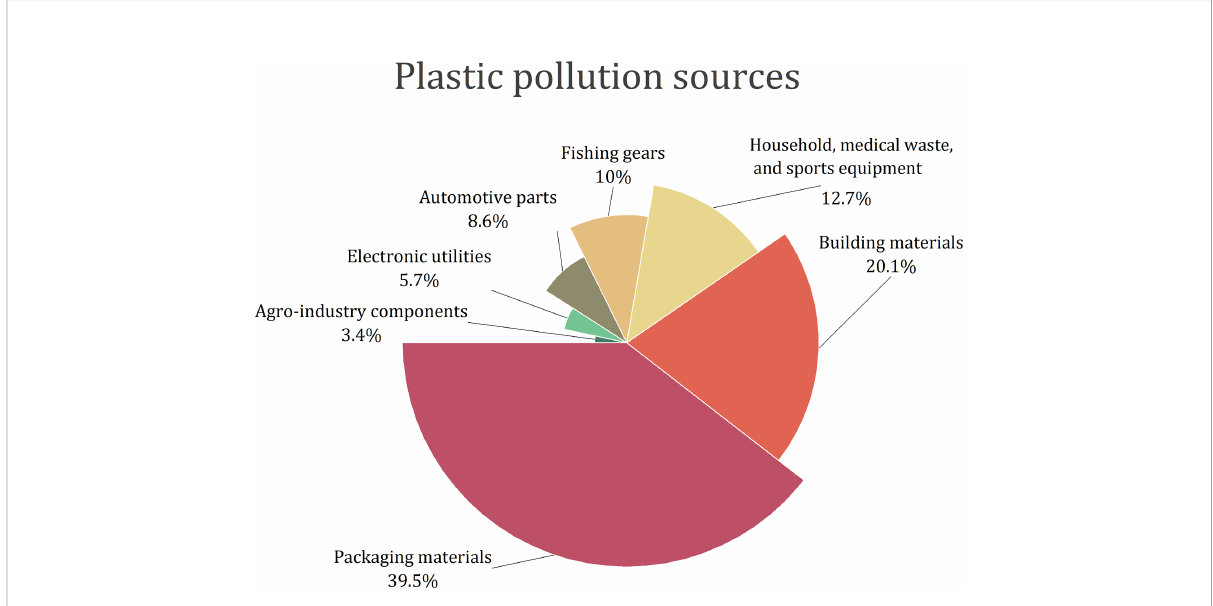
FIGURE 2 Plastic pollution sources (Horton et al., 2017; Pinto Da Costa et al., 2020; Kiran et al., 2022; Law and Narayan,